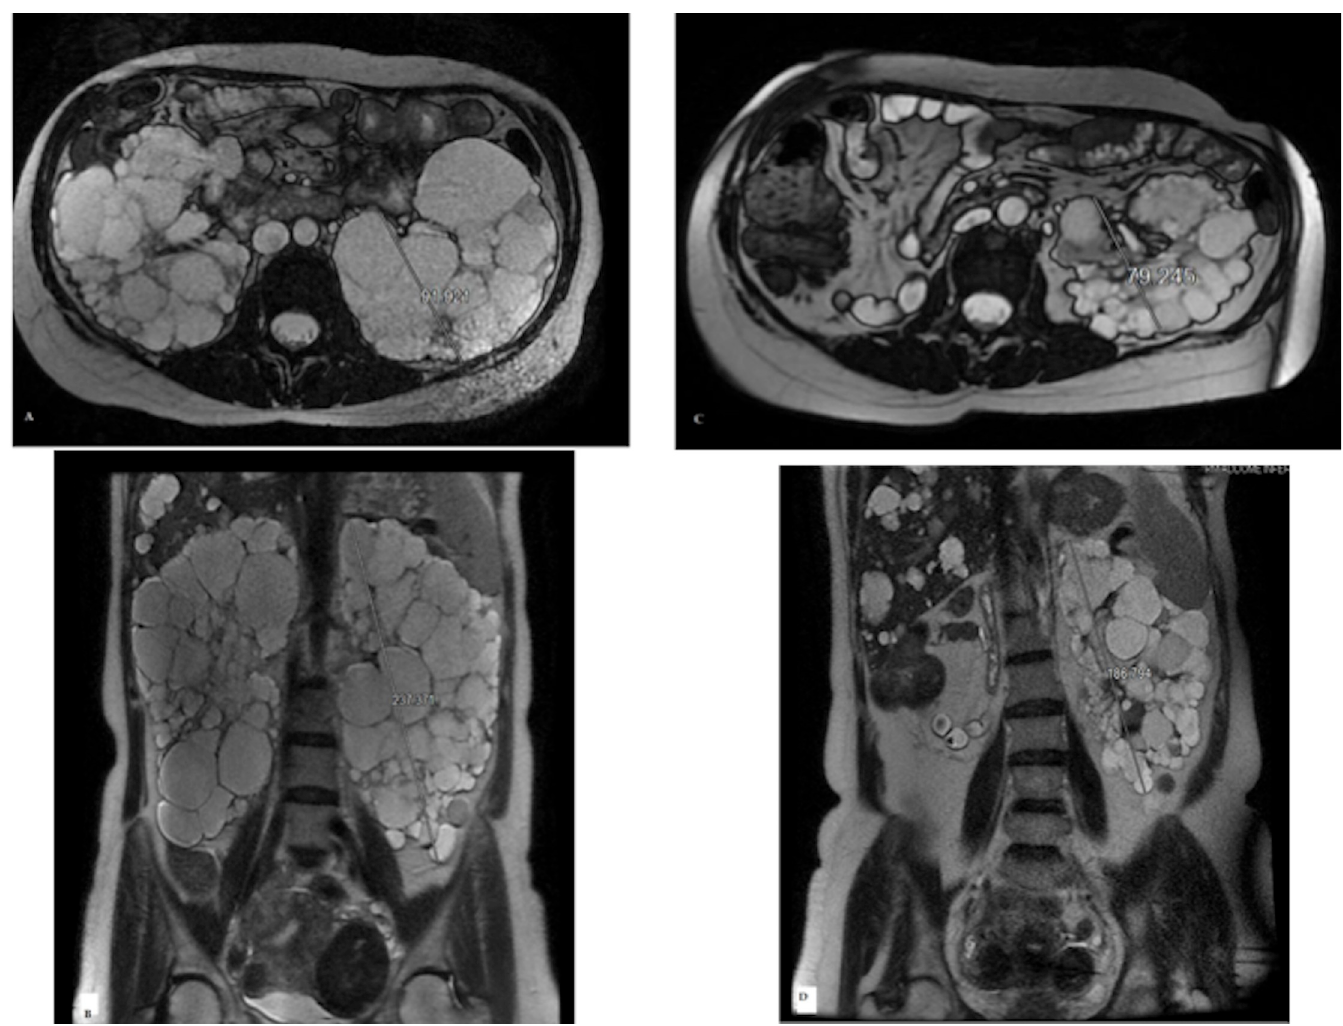
Fig 2. Magnetic resonance imaging of a 52 year-old woman, with end-stage renal disease due to autosomal dominant polycystic kidney disease. Pretransplant Axial T2 weighted (A) and Coronal T2 weighted images (B) demonstrated a massive enlargement of both kidneys with the lower pole in the iliac fossa. The patient underwent a kidney transplantation with simultaneous right nephrectomy, and 1-year Axial T2 weighted (C) and Coronal T2 weighted images (D) demonstrated a significant reduction of kidney volume.